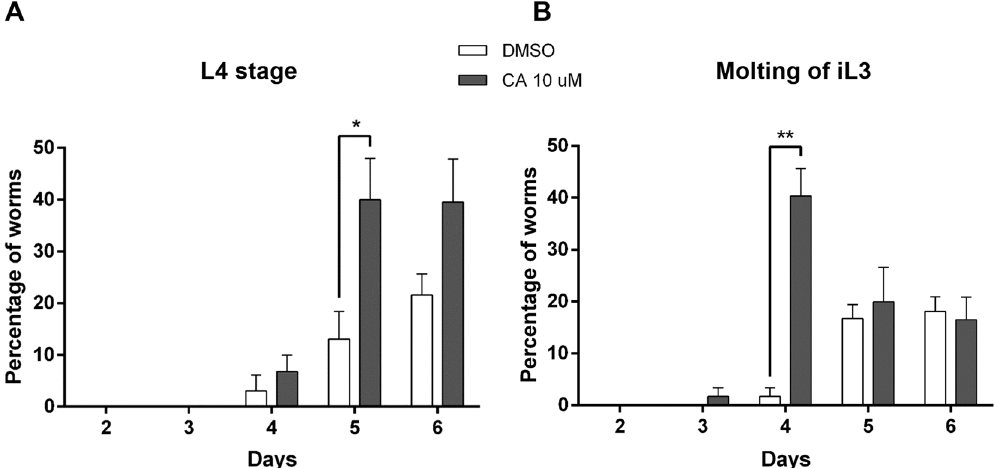
Figure 8. Cholestenoic acid accelerates the complete molting of infective third stage D. immitis larvae to L4. The iL3 stage larvae were collected from mosquitos and treated with cholestenoic acid (CA) or DMSO ( A ). The panel) found in the wells corresponded to larvae that had completed the molt and were L4. The figure shows a representative experiment performed in quadruplate using Prism 6.0 (Graph Pad Software, Inc.). The